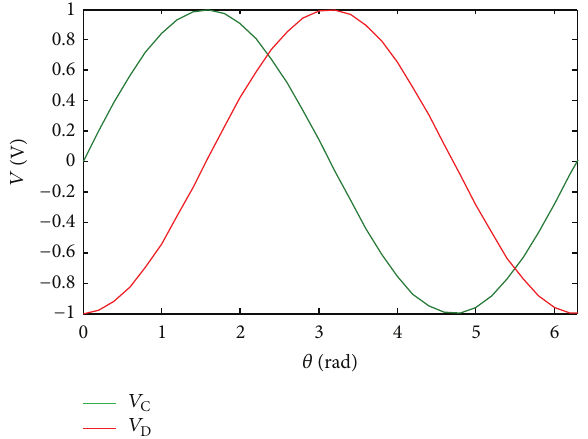
Figure 1: The relationship between the voltage of C-Signal and D- Signal and mechanical angle of